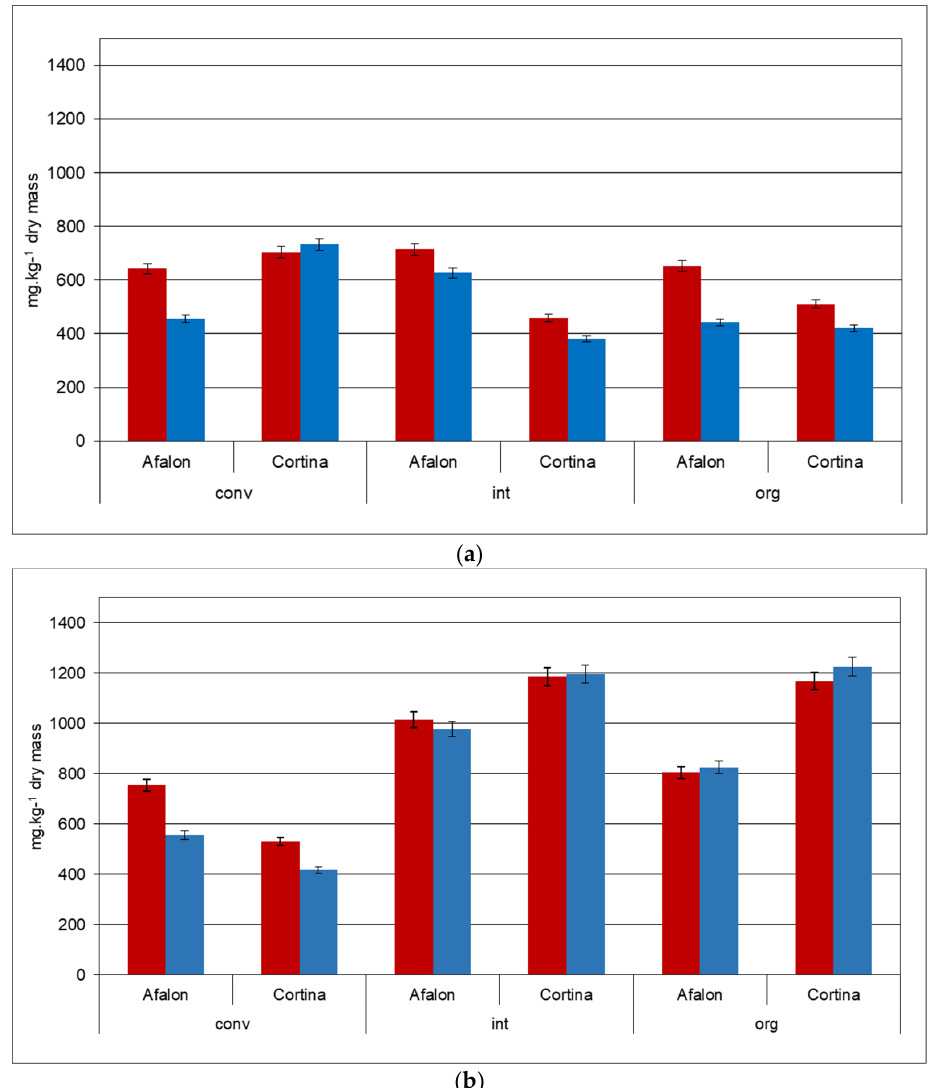
Figure 2. Content of β -carotene and α -carotene in Cortina and Afalon cv. Produced in conventional (conv), integrated (int), and organic (org) systems: ( a ) seeding density 6 × 10 5 seeds.ha − 1 ; ( b ) seeding density 9 × 10 5 seeds.ha − 1 . The level of carotenes is expressed in mg per kg DW; β -carotene, red; α -carotene, blue.